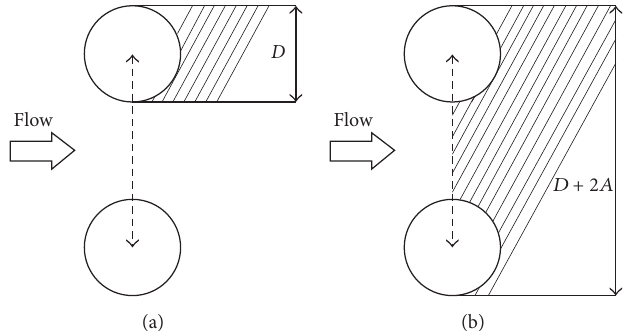
Figure 2: The projected area for the calculation of power in fluid 𝑃 𝑤 . (a) The projected area of cylinder; (b) the projected area of the vibration.